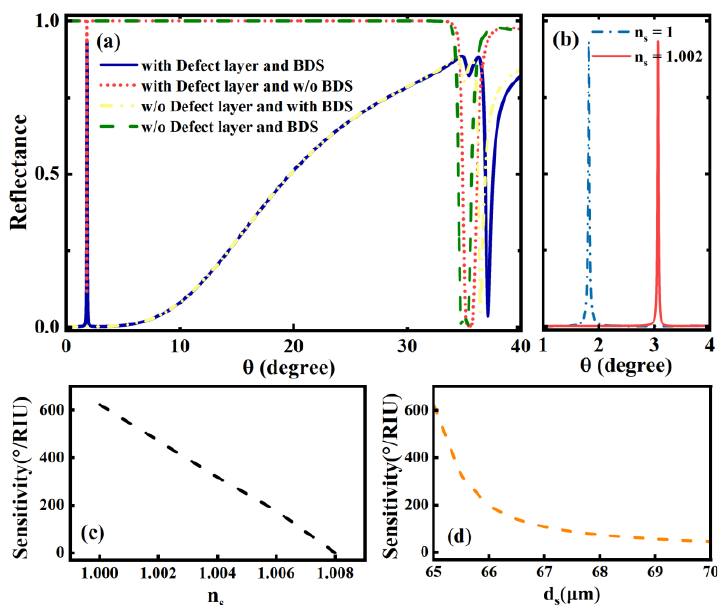
Figure 5. ( a )The structure when used as a gas biosensor. Curves of reflectance versus incident angle for the cases: loaded BDS and defect layer (blue solid line), loaded defect layer but no BDS layer (red short dotted line), loaded BDS but no defect layer (yellow double-dotted line), and no BDS and defect layer (green dashed line); ( b ) reflectance cases at different refractive indices of the sensing layer; ( c ) the variation curve of the sensitivity of the structure with respect to the refractive index of the sensing layer; ( d ) the variation curve of the sensitivity of the structure with respect to the thickness of the sensing layer.